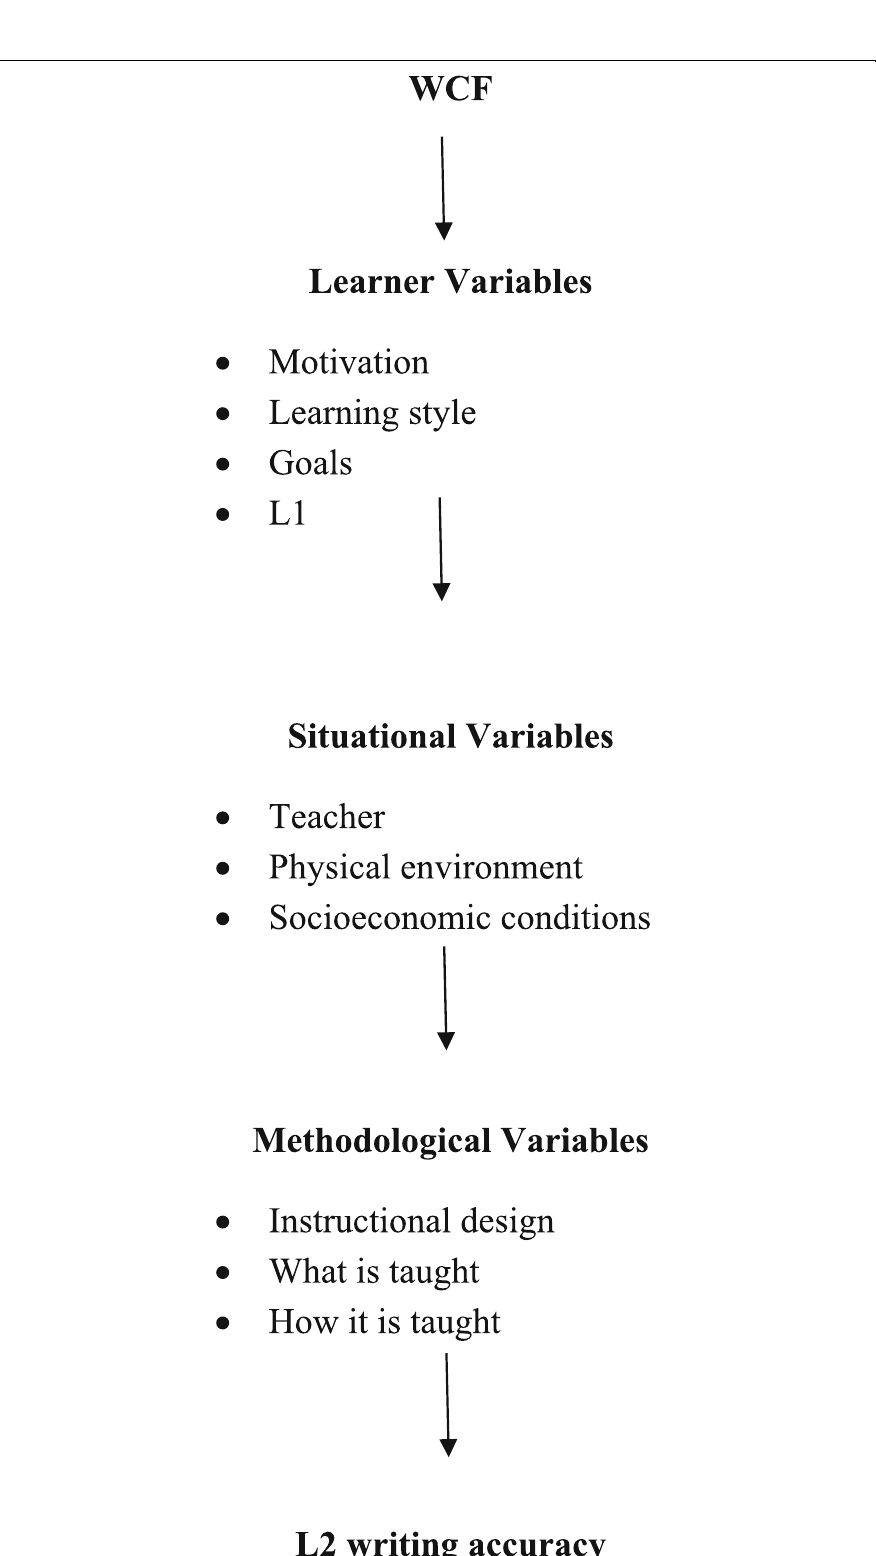
Fig. 1 Contextual factors in L2 writing influencing learning and